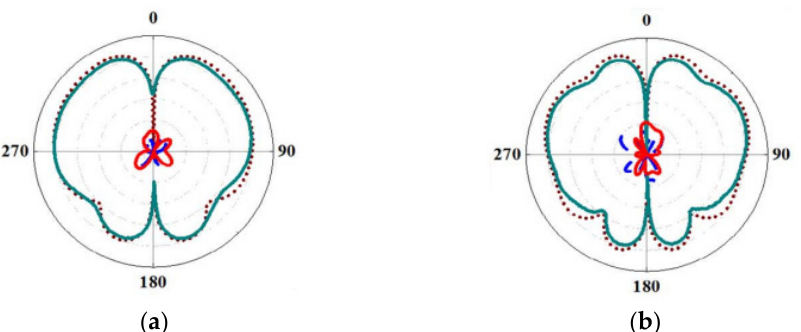
Figure 28. Conical radiation pattern of the proposed antenna in E-plane at: ( a ) 33 GHz; ( b ) 41 GHz [116].